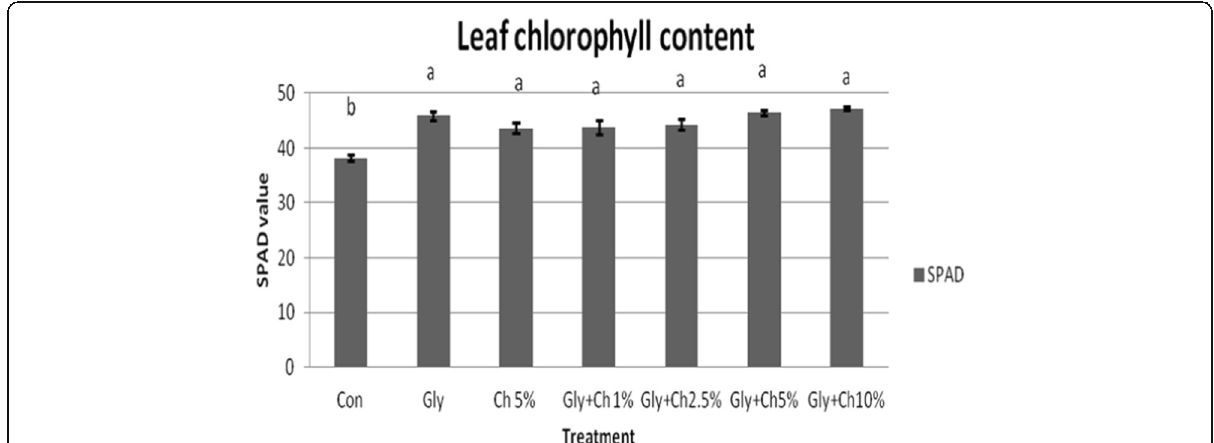
Fig. 2 Soil plant analysis (SPAD) values showing leaf chlorophyll content of winter wheat seeds (cv. Isengrain) after 12th of seeding. Every data point show average treatment values of four independent replicates. Error bars indicating standard error. Different letters indicating significant differences ( α =